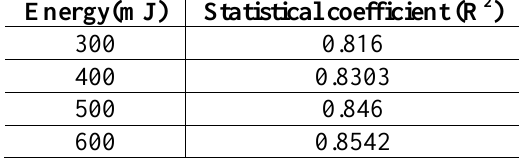
Table 2: Laser Energy and Statistical Coefficient (R 2 ).